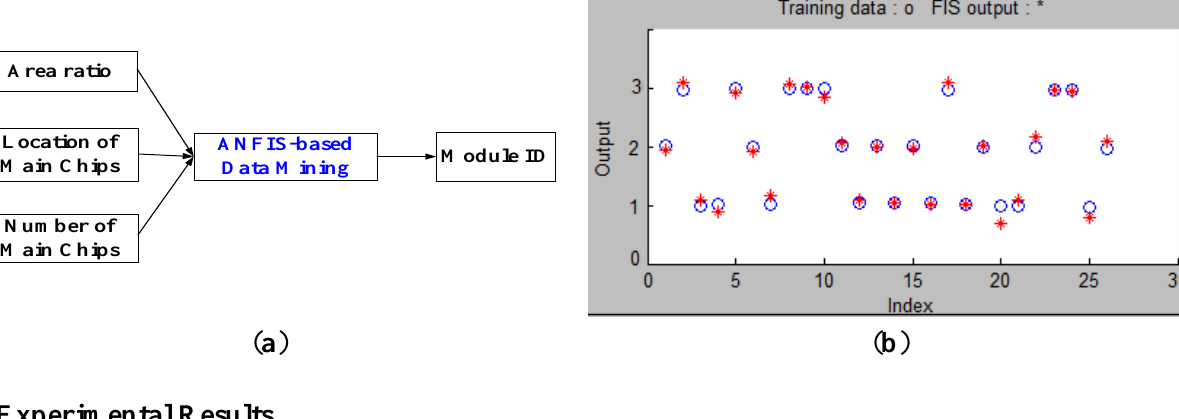
Figure 14. ( a ) The architecture of ANFIS-Based training system; ( b ) The ANFIS training